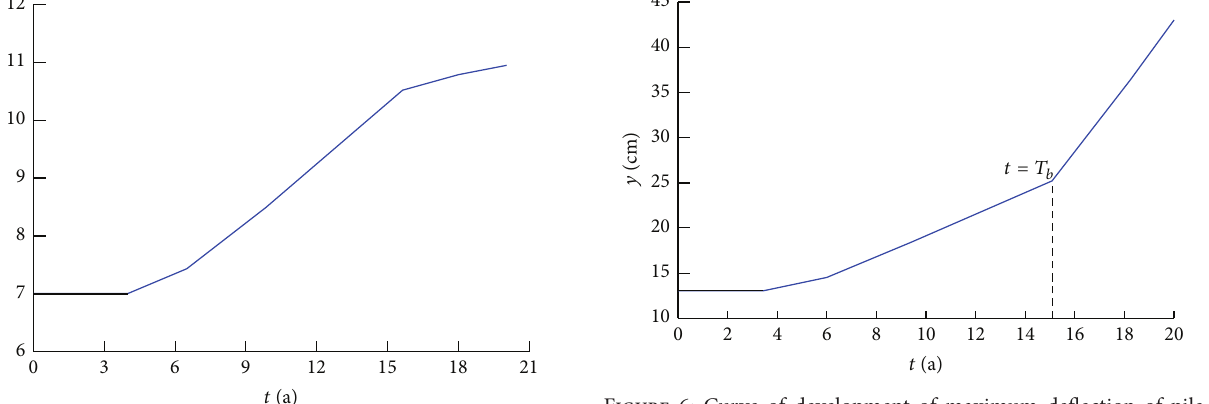
Figure 6: Curve of development of maximum deflection of pile foundation under the condition of extreme load.